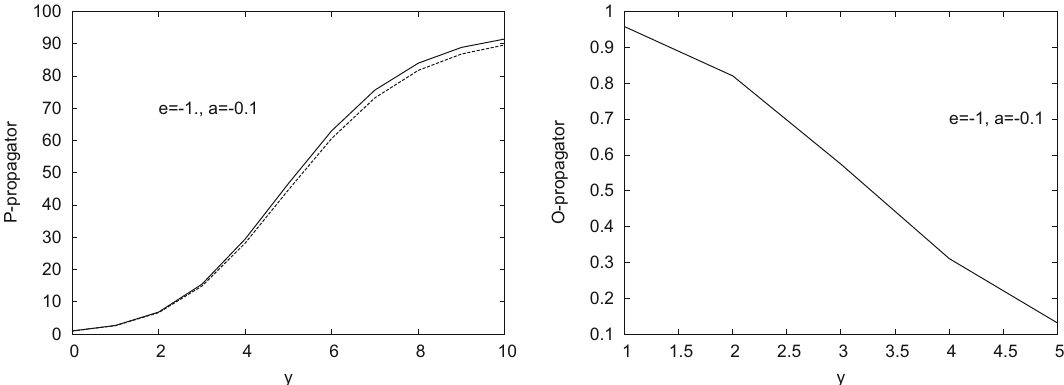
Fig. 6 The solid curves show pomeron (left panel) and odderon (right panel) propagators as functions of rapidity for μ = 1, λ = 0 . 1. The dashed curve in the left panel shows the pomeron propagator in the absence of the odderon (only pomeron loops)